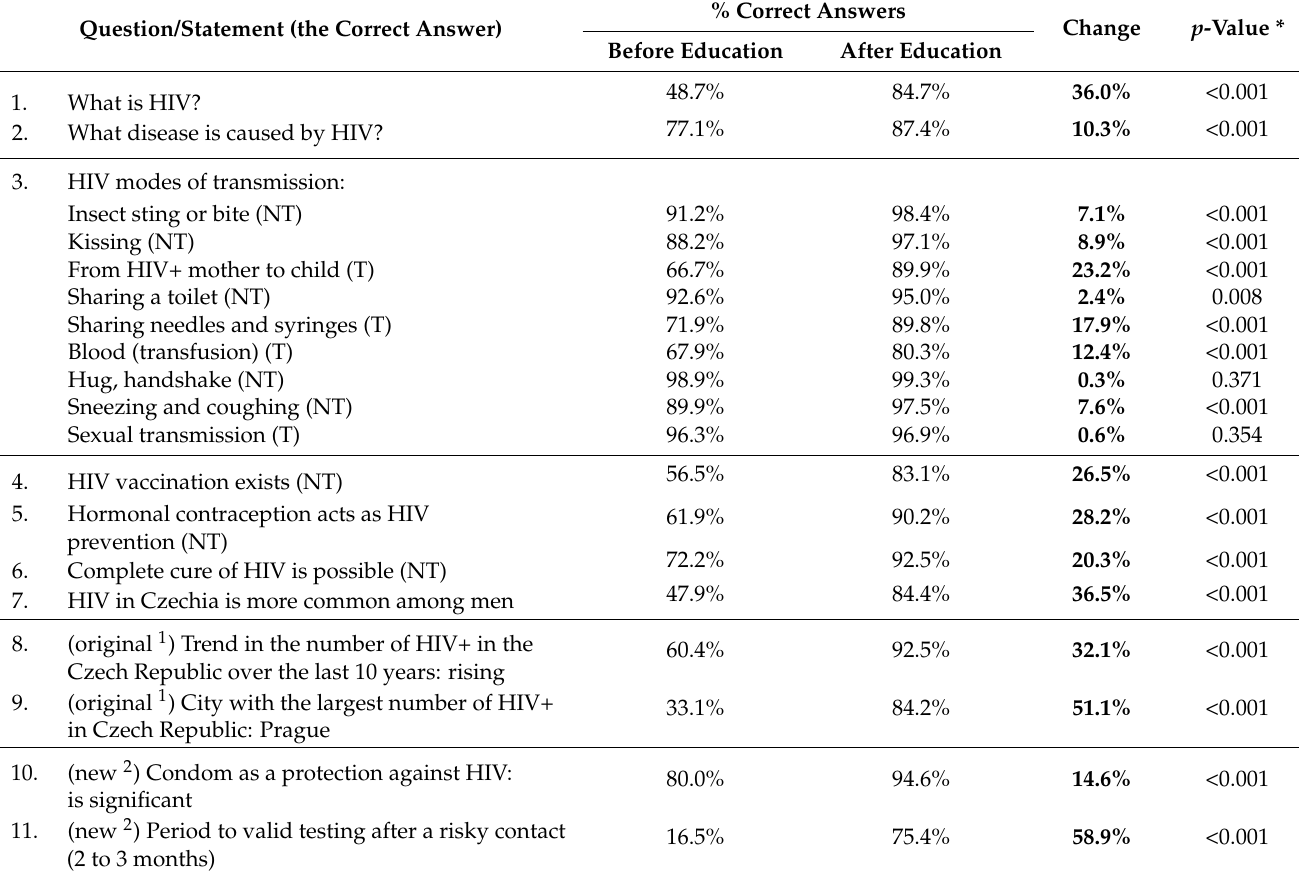
Table 2. Selected questions and correct answers before and after education ( n =